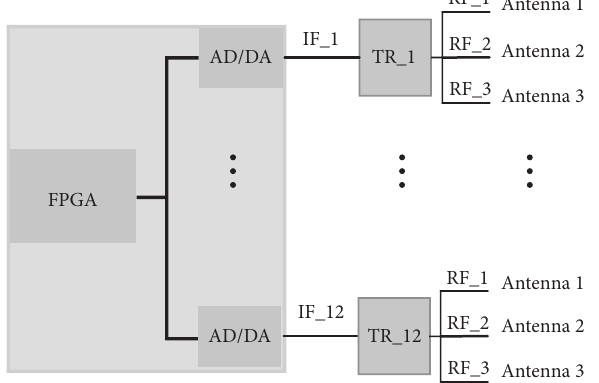
Figure 2: A sub-array of the cylindrical